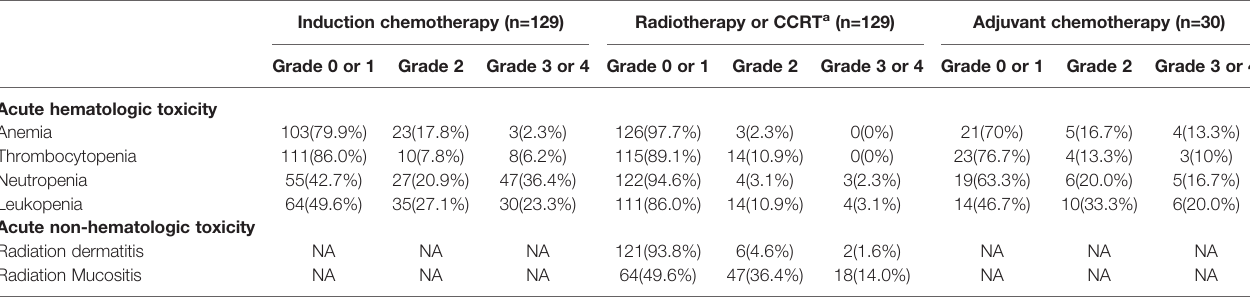
TABLE 4 | Summary of treatment-related